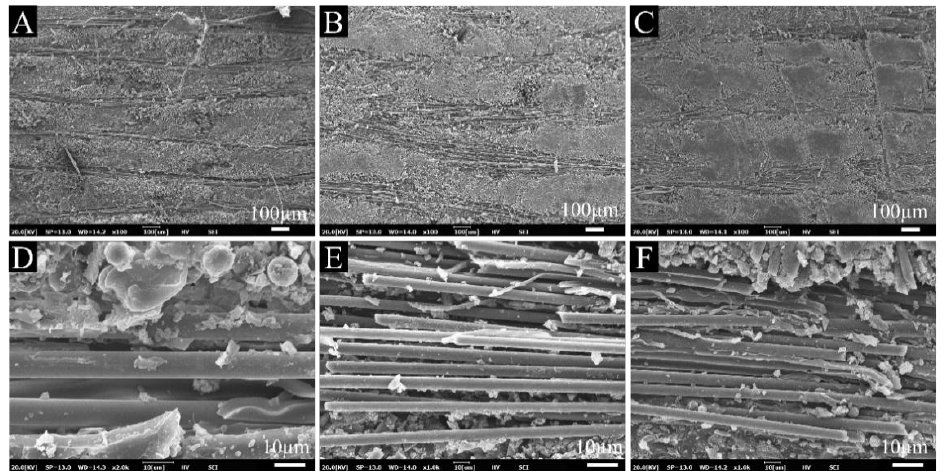
Figure 2. SEM images of epoxy composites reinforced with ( A ) CF, ( B ) GF, ( C ) CF/GF, and ( D – F ) magnified images of composites ( A – C ), respectively. magnified images of composites ( A – C ),